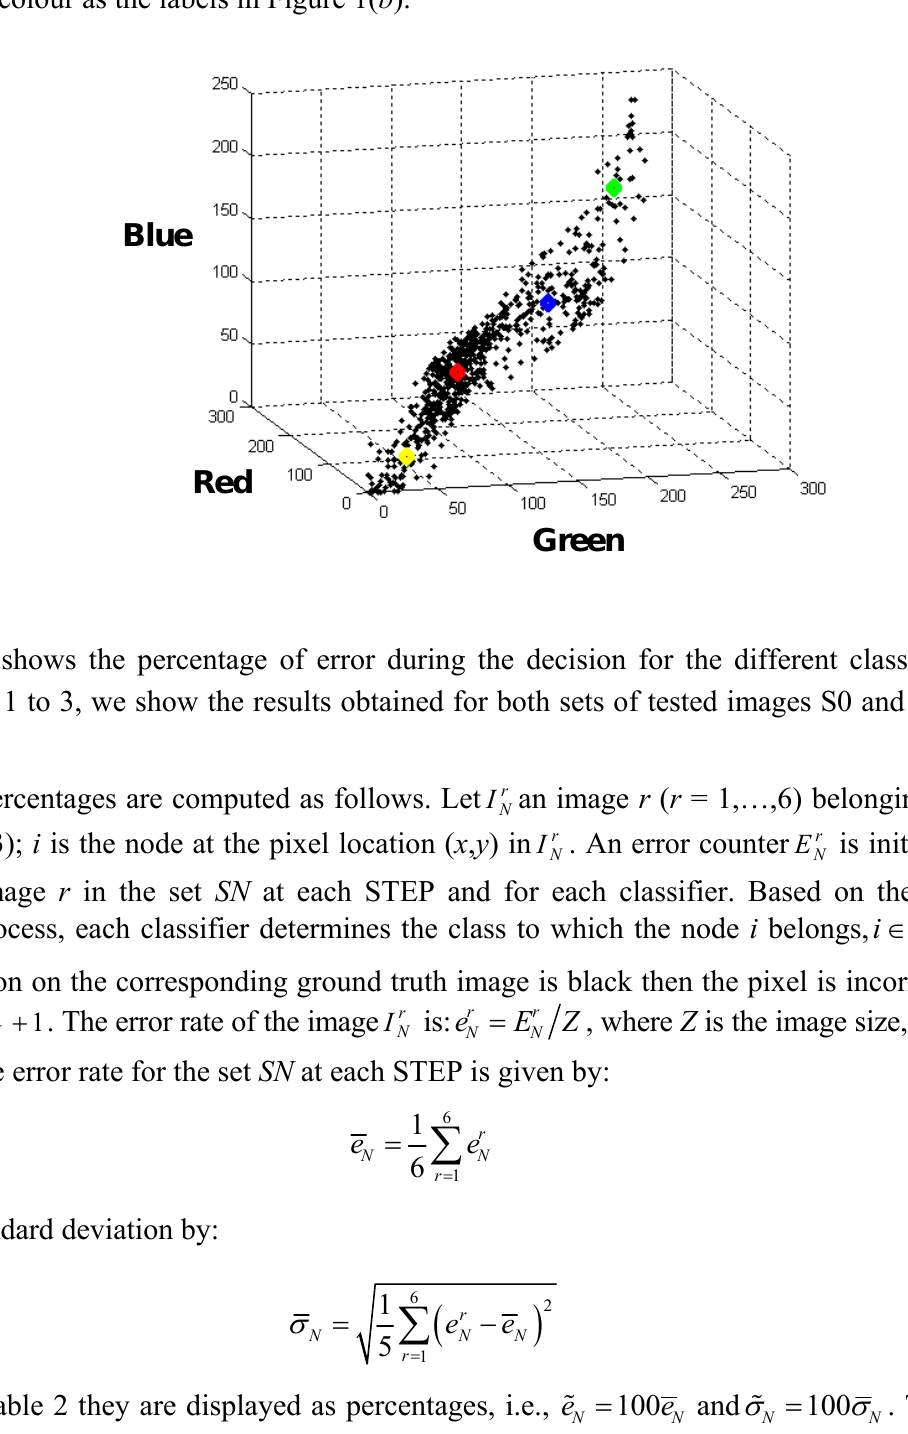
Figure 2. Distribution of a subset of 4,096 patterns into the four estimated classes around the cluster centres of the classes in the colour space RGB. The centres are displayed in the same colour as the labels in Figure 1( b